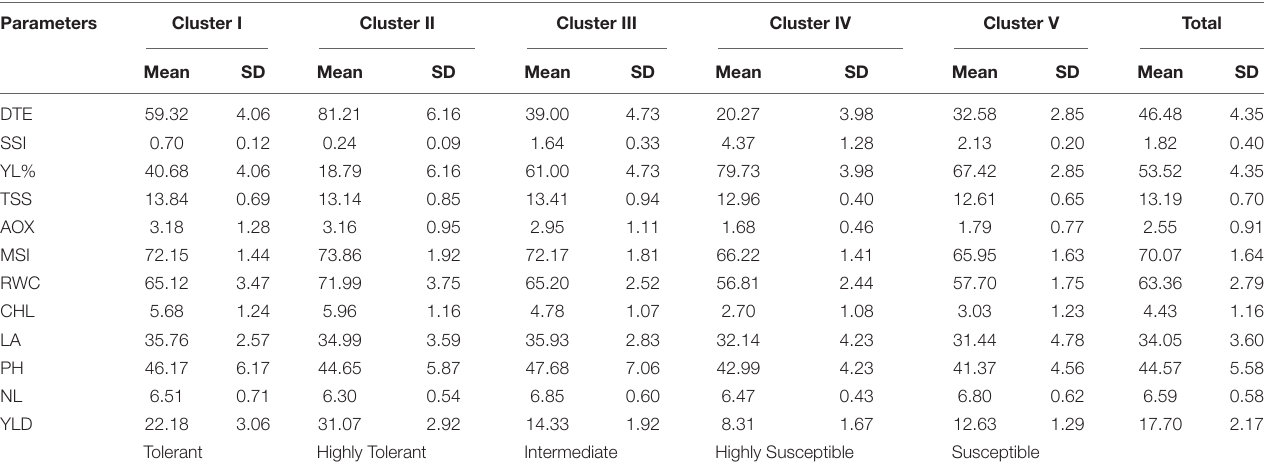
TABLE 6 | Descriptive statistics for all traits of 100 onion genotypes under different